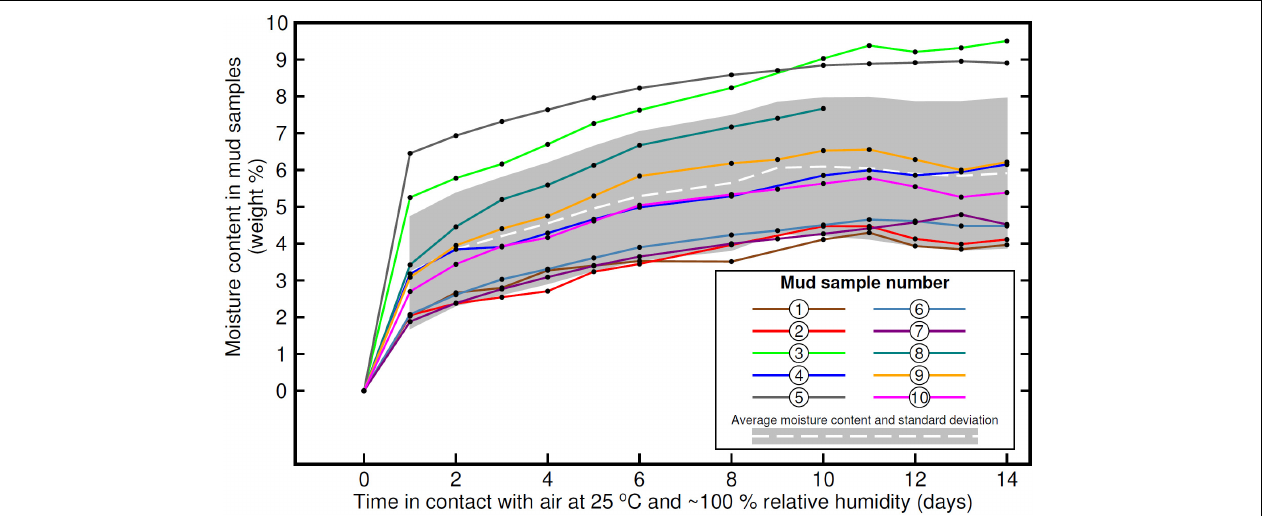
FIGURE 4 | Time-series of adsorption of water to pre-dried (at 105 ◦ C) mud fragments from the inner wall of a mud house while exposed to air with ∼ 100 % relative humidity at 25 ◦ C. The running average and its standard deviation are shown by a white dashed line and a gray band, respectively.